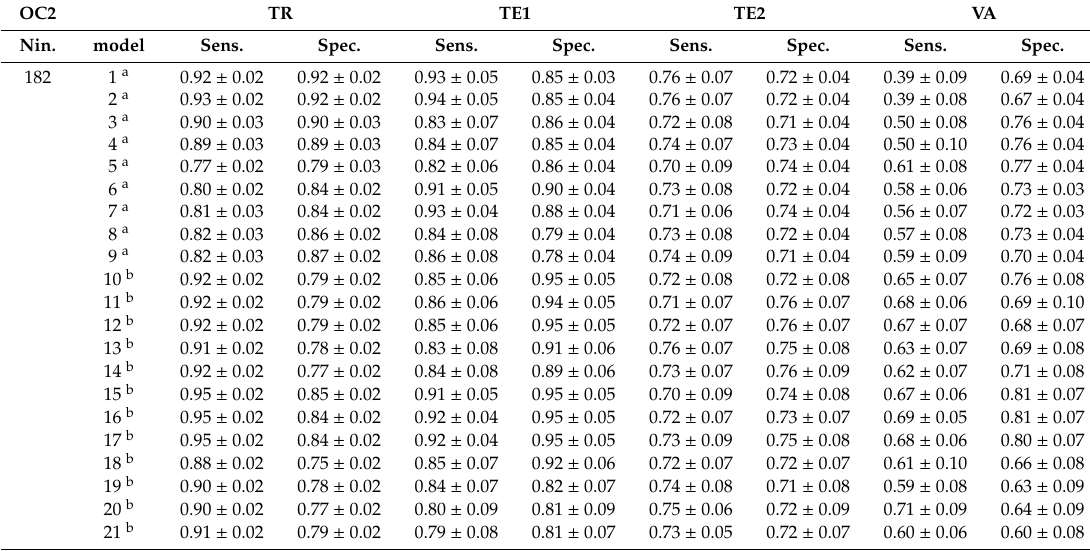
Table 3. The average values of sensitivity and specificity obtained for models optimized using optimization criterion 2. Average values and standard deviations are given for 100 models built using selected descriptors and di ff erent permutations of objects in training